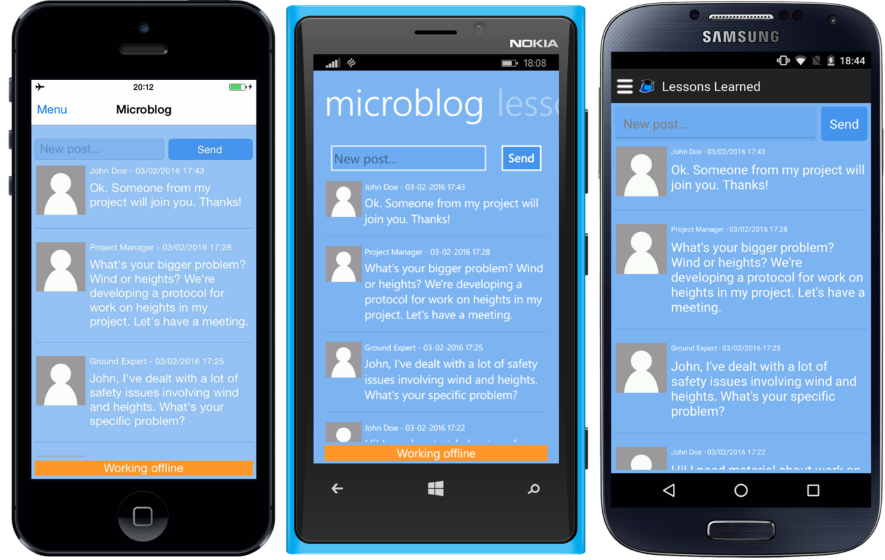
Figure 8. Native, yet similar, Microblog UIs for iOS, Windows Phone, and